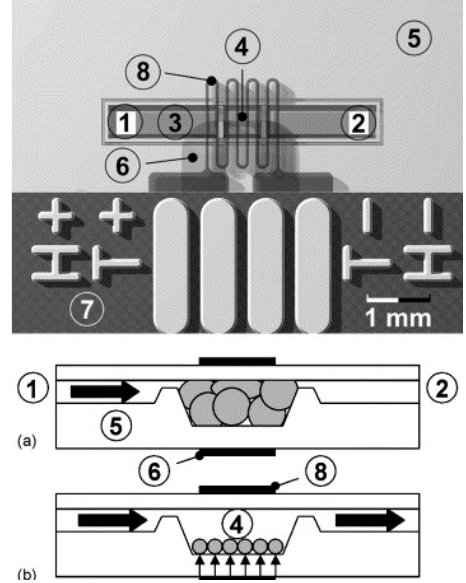
Figure 25. Schematic design of a hydrogel-based microvalve: 1, inlet; 2, outlet; 3, flow channel; 4, actuator chamber filled with hydrogel particles; 5, structure layer; 6, heating meander (located at backside); 7, circuit card; 8, temperature sensor (located at topside); ( a ) closed state at room temperature; ( b ) open state (gel actuator is heated above TC). Reprinted from Reference [199] with